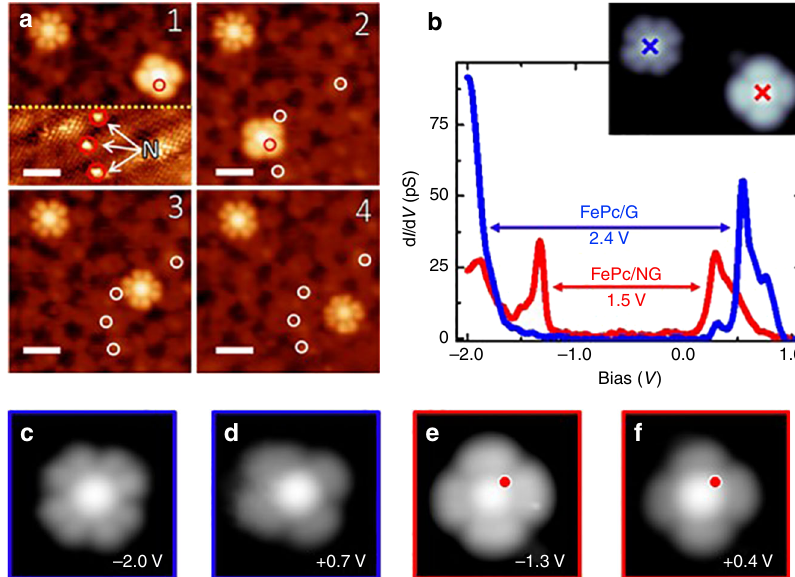
Fig. 2 Effect of N-dopant on the FePc electronic structure. a STM images acquired after steps of controlled lateral manipulation of FePc on N-doped graphene. From the initial situation (1), where a FePc molecule is adsorbed on an N-dopant, the molecule was moved to a different con fi guration on another N-dopant (2), then to a distance of 1.3 nm from any N-dopant (3), and fi nally to pristine graphene (4). The circles mark the positions of the N-dopants. The FePc molecule in the top left is located on pristine graphene and served as a reference. The scale bar corresponds to 2 nm. b d I /d V spectra acquired at the center of FePc on pristine graphene (blue) and on an N-dopant (red). 3.6 nm × 3.6 nm STM bias-dependent images (I t = 10 pA) of FePc on pristine graphene ( c , d ) and on an N-dopant ( e , f ), acquired at biases near the resonances shown in the dI/dV spectra ( b